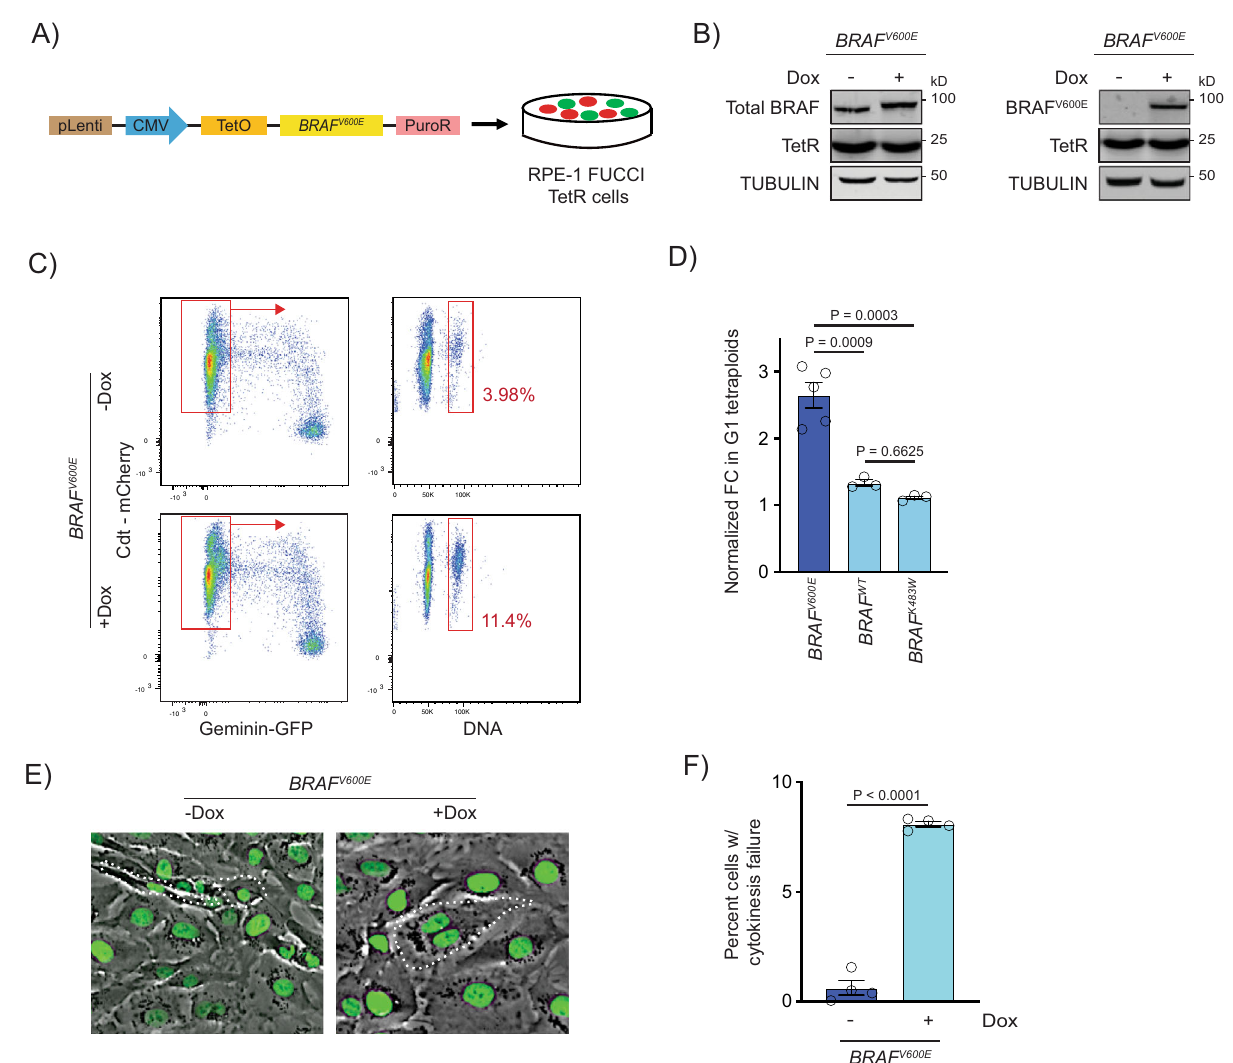
Fig. 2 BRAF V600E -induced binucleate, tetraploid cells arise via cytokinesis failure. A Generation of BRAF V600E -expressing RPE-1 FUCCI cell lines with a lentiviral-based doxycycline-inducible vector. B Western blot showing inducible expression of BRAF V600E ( + Dox) in RPE-1 FUCCI cells using a BRAF and BRAF V600E -speci fi c antibody. Expression of the Tet repressor protein is shown. TUBULIN was used as the loading control. A representative of three independent biological replicates is shown. C Flow cytometry plots of control ( − Dox) and BRAF V600E -expressing ( + Dox) RPE-1 FUCCI cells. Tetraploid cells accumulating in G1 were quanti fi ed based on Cdt1-mCherry positivity and Hoechst incorporation. Percentages of G1 tetraploid cells in control and BRAF V600E -expressing cultures are indicated. D Fold change (FC) in G1 tetraploids normalized to the control ( − Dox) are shown for BRAF V600E , BRAF WT and BRAF K483W (kinase-dead) -expressing RPE-1 FUCCI cell lines. N = 5 independent experiments for BRAF V600E , N = 3 for BRAF WT and N = 3 for BRAF K483W . One-way ANOVA with Tukey ’ s multiple comparisons test. Error bars represent mean ± SEM. E Merged phase contrast and GFP photomicrographs of